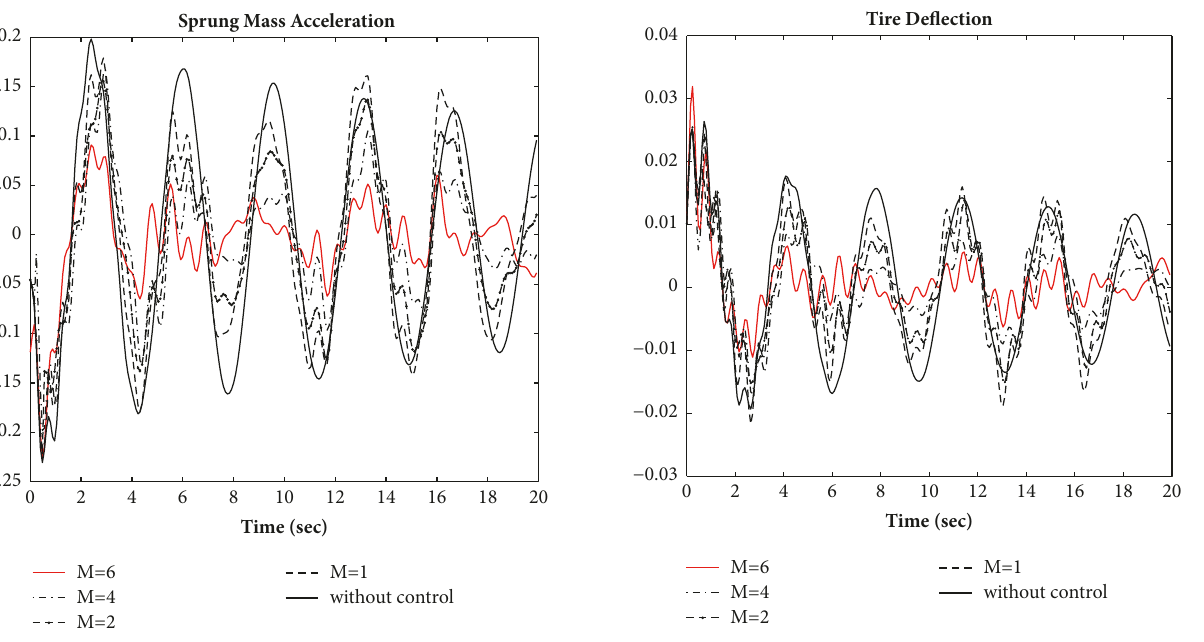
Figure 4: The curve of the sprung mass acceleration ̈𝑧 𝑠 (𝑡) .